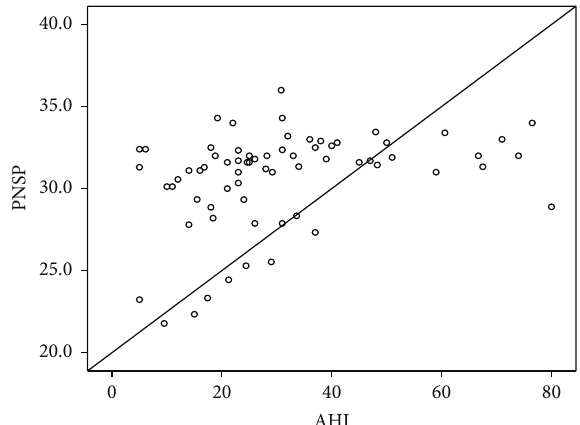
Figure 3: Bar diagram showing association of lateral cephalometric variables with retroglossal region.